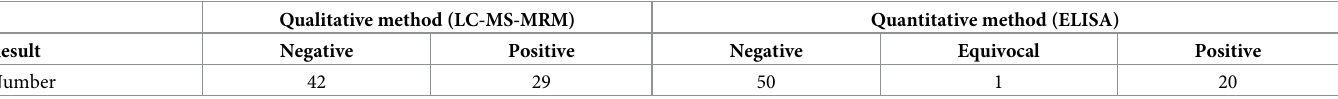
Table 5. Total number of positive, negative and uncertain results in the quantitative (ELISA) and qualitative (LC-MS-MRM) podocin evaluation in all the examined horses.